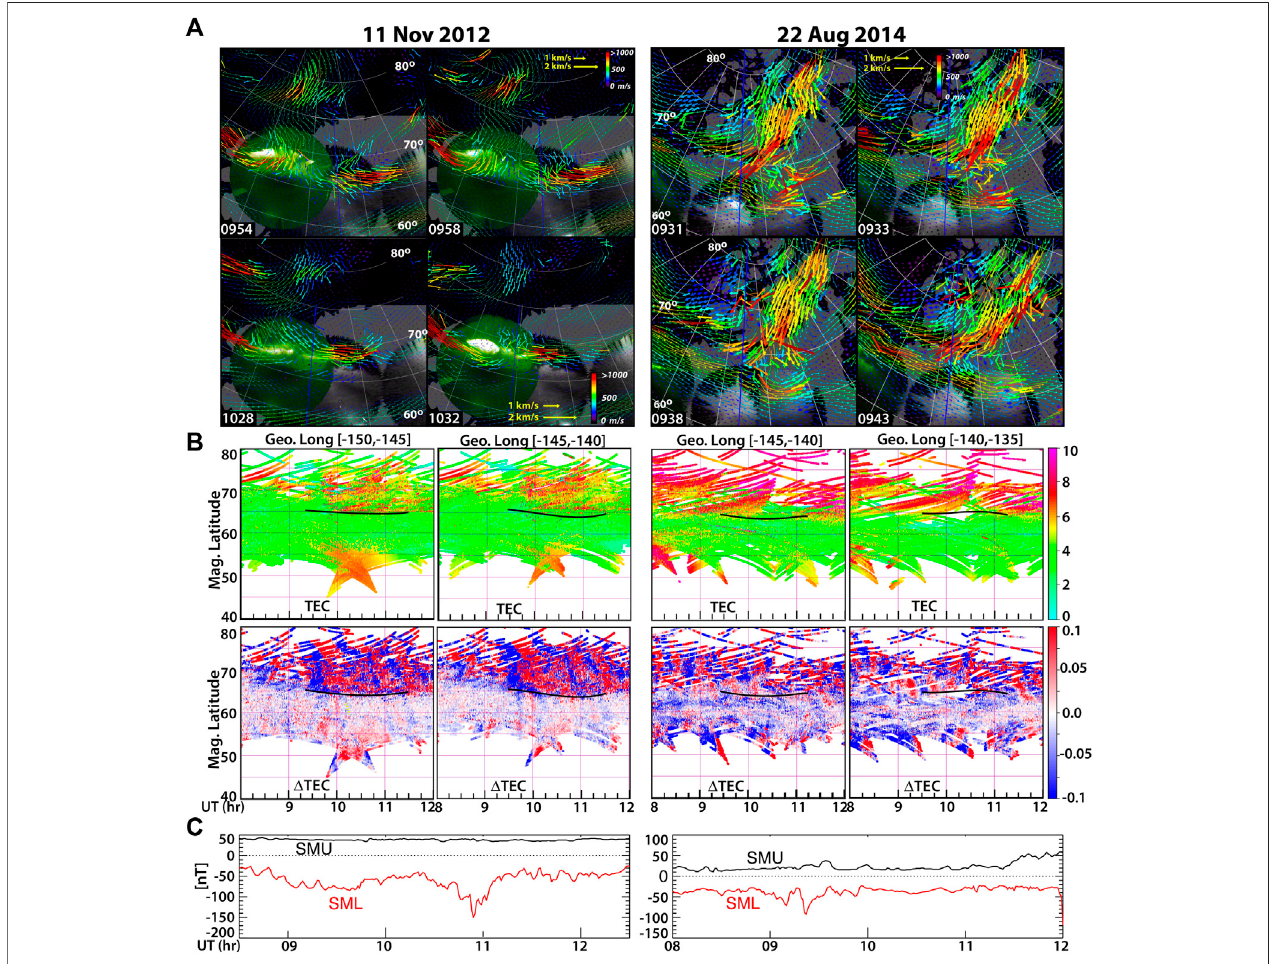
FIGURE 13 | Examples having well de fi ned fl ow channels as seen in the SuperDARN fl ow vectors. (A) Two separate fl ow channels are shown from November 11, 2012,onenear0956UTandtheothernear1030UTandonefromAugust22,2014. (B) AverageTECand Δ TECover5 ° geographiclongitudeincrementsfromnearand 5 ° east of,Poker Flatonthe abovetwodatesinthesameformatas Figure4 , except withoutdashed lines identifying features. (C) SuperMAG Uand Lindices(SMUand SML) for the above two